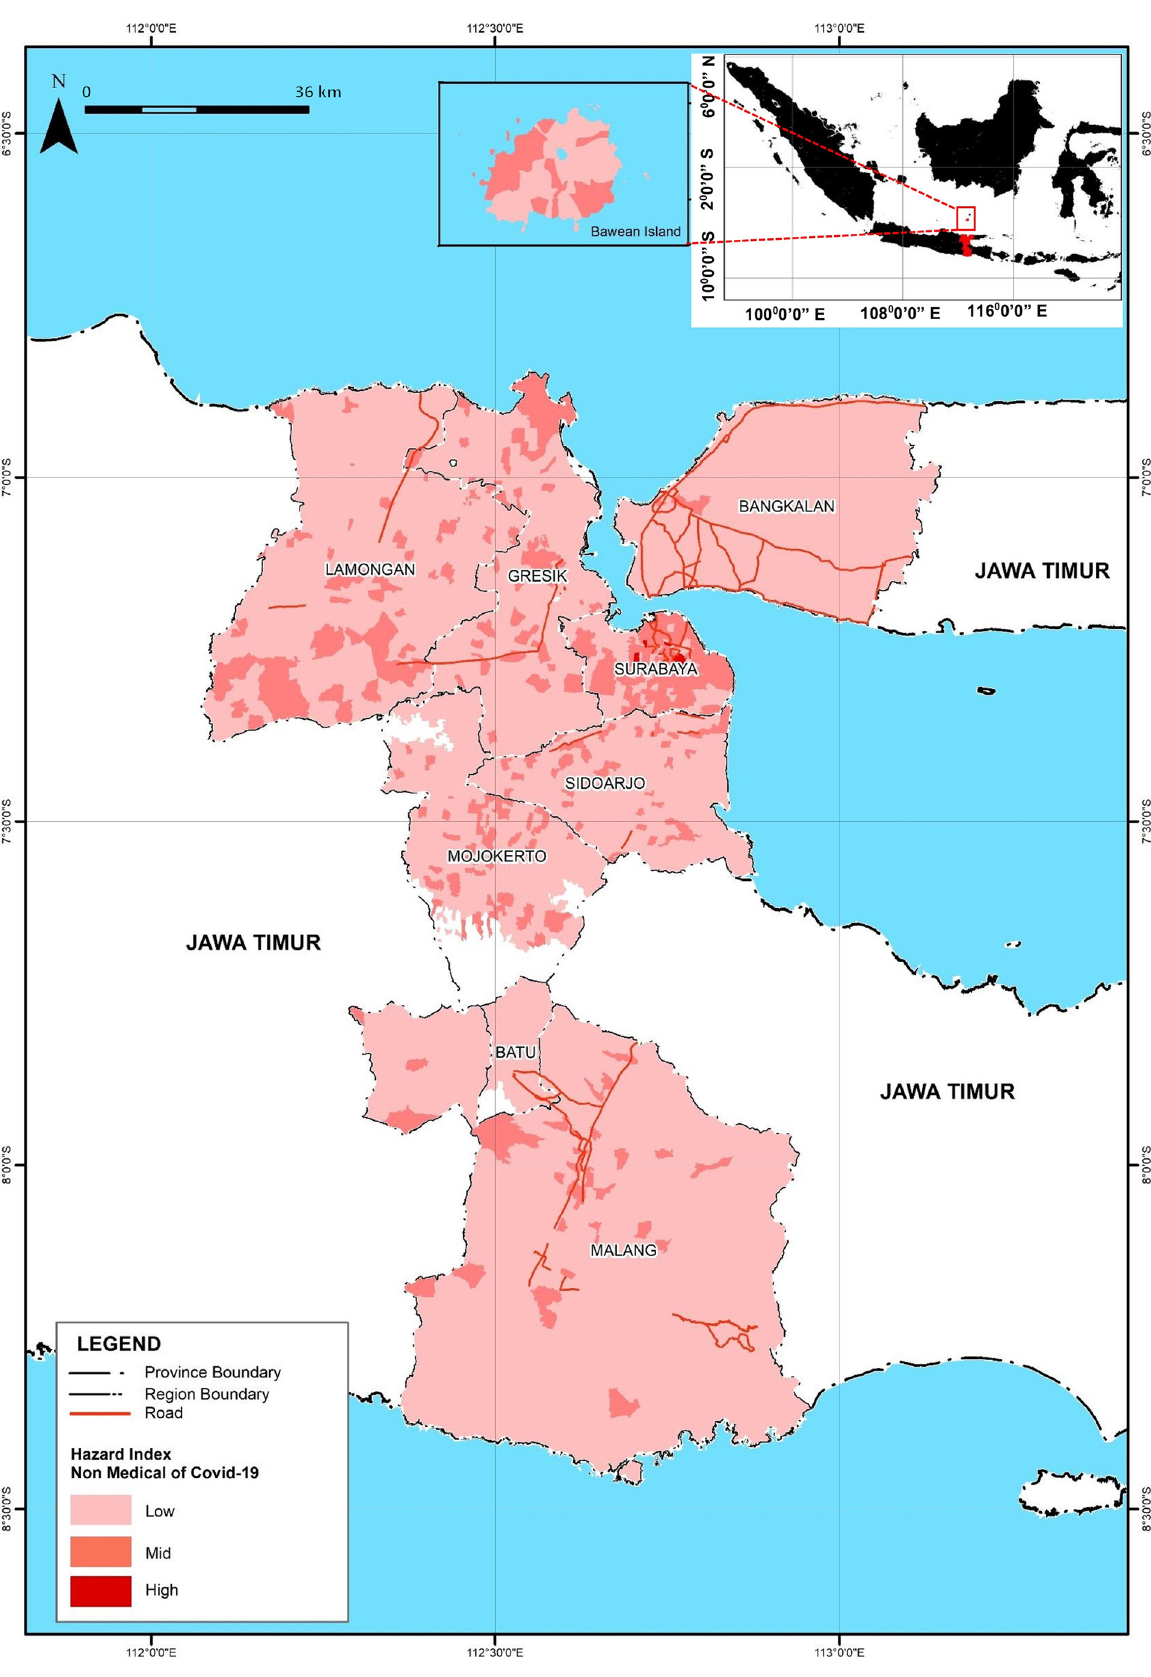
Fig. 7. COVID-19 hazard index of Gerbangkertosusila-Bama (Greater